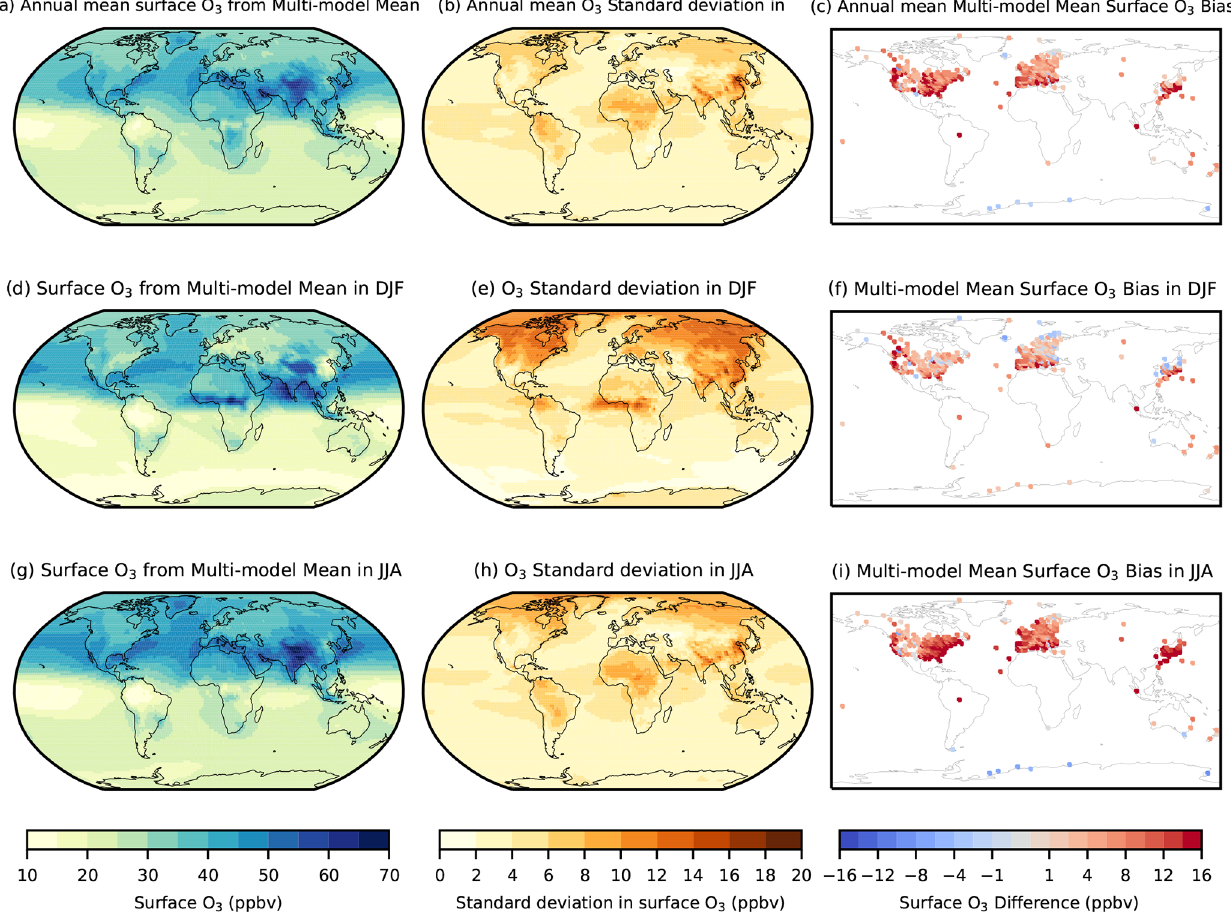
Figure 3. Multi-model (six CMIP6 models) annual and seasonal mean surface O 3 concentrations over the 2005–2014 period in (a) annual mean; (d) December, January and February (DJF); and (g) June, July and August (JJA). The SD of the multi-model mean in (b) annual mean, (e) DJF and (h) JJA. The difference between the multi-model mean and TOAR observations in (c) annual mean, (f) DJF and (i) JJA (colour bar